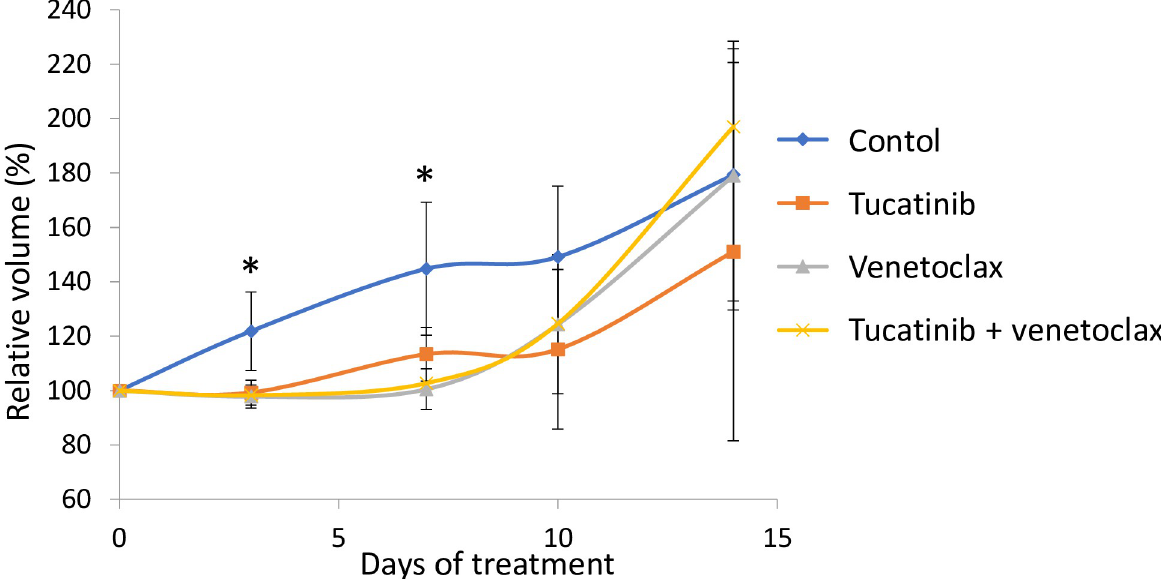
Fig 5. Treatment efficacy of tucatinib and venetoclax in vivo . Nude mice with unilateral KPL4 tumors were treated five days per week with tucatinib (25 mg/kg), venetoclax (25 mg/kg), or a combination of the two, or with only vehicle. The figure shows relative tumor volumes (%) compared to volume at the start of treatment. Error bars indicate standard error of the mean, n = 6 mice per group. � p < 0.05 between treatment groups and control, Wilcoxon rank-sum test.